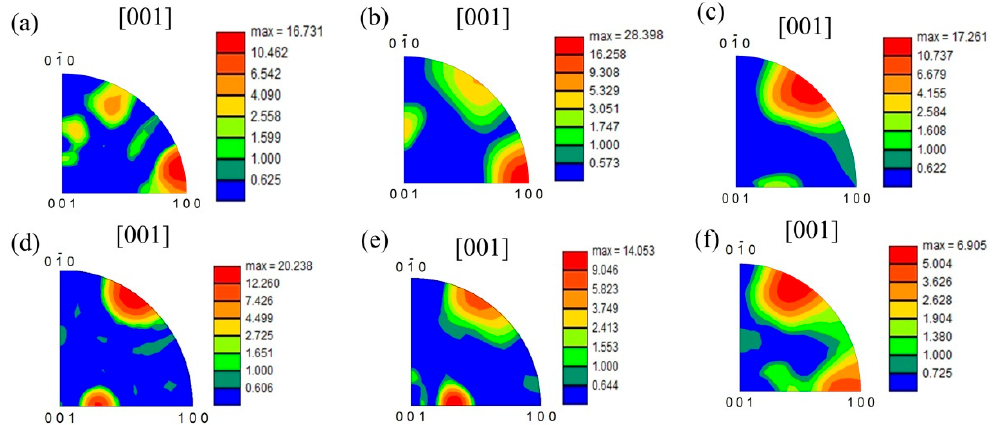
Figure 10. O phase IPF of the as-rolled and can-compressed Ti 2 AlNb samples subject to annealing treatment: ( a ) as-rolled, ( b ) 25%, ( c ) 50%, ( d ) 60%, ( e ) 65%, and ( f ) 75%.